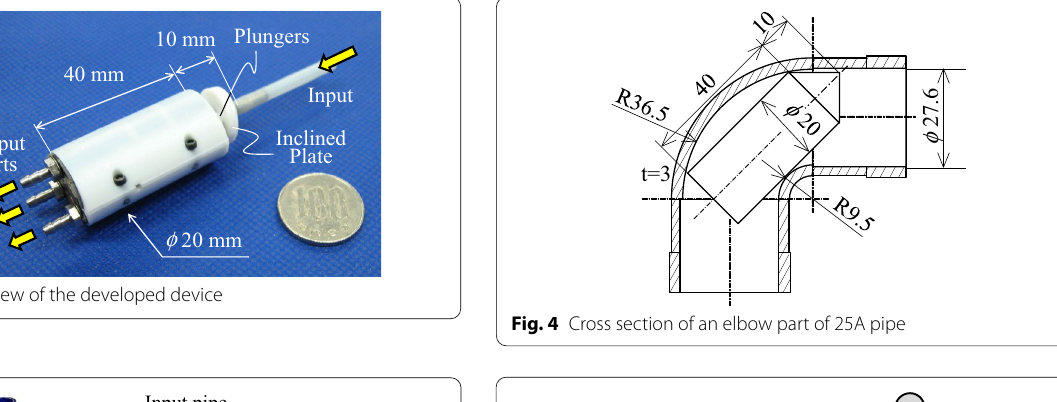
Input pipe (connect to the air pressure source)